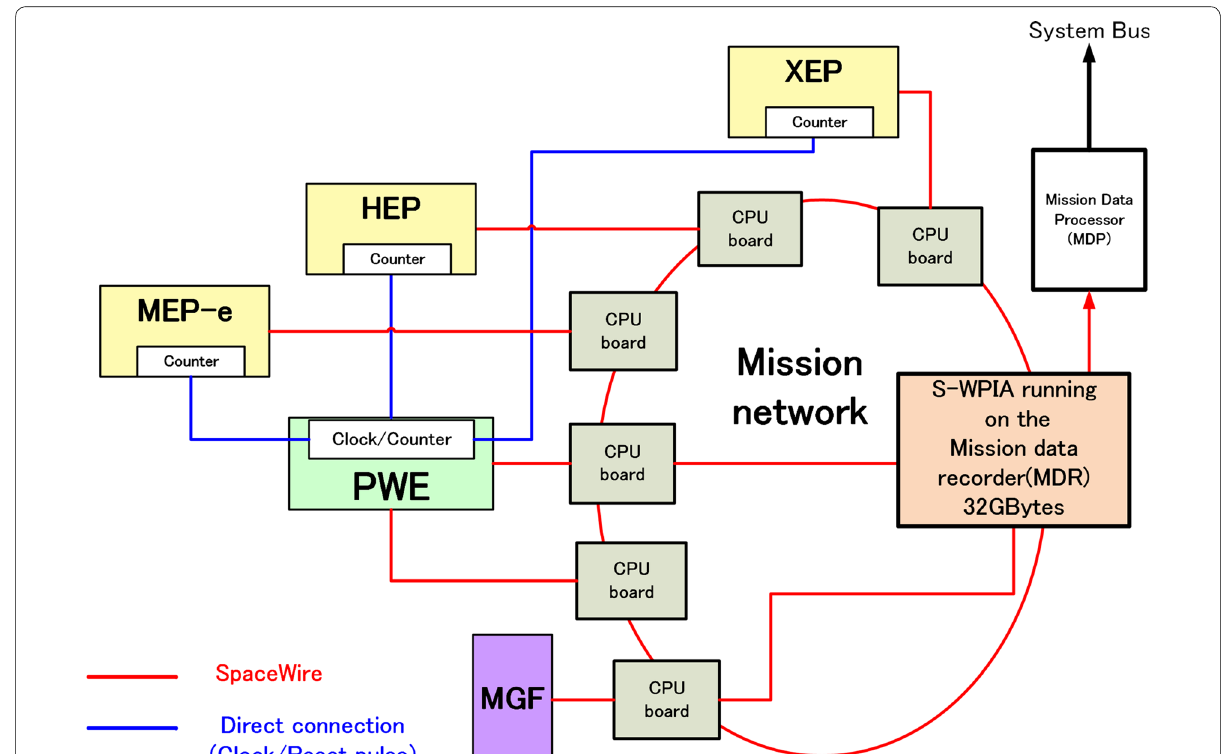
Fig. 3 Configuration of the mission network among the cooperated instruments of the